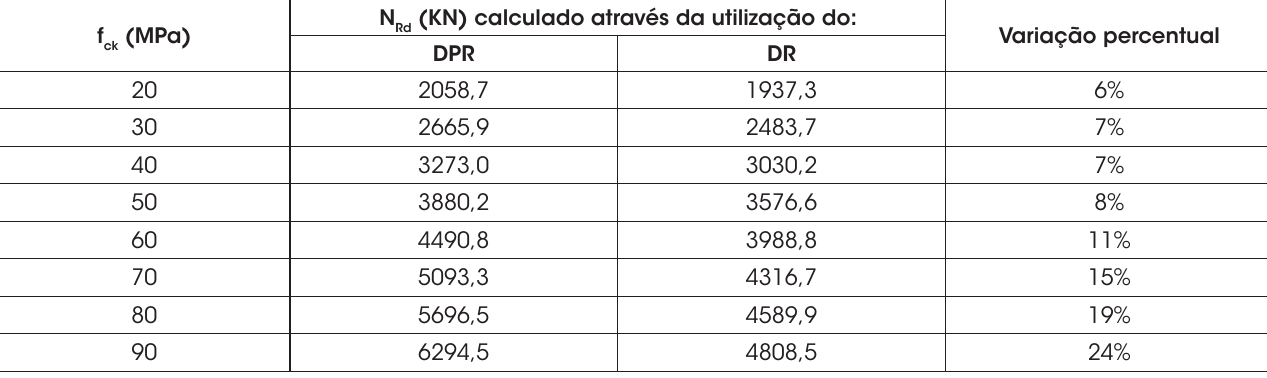
DPR = Diagrama Parábola Retângulo; DR = Diagrama